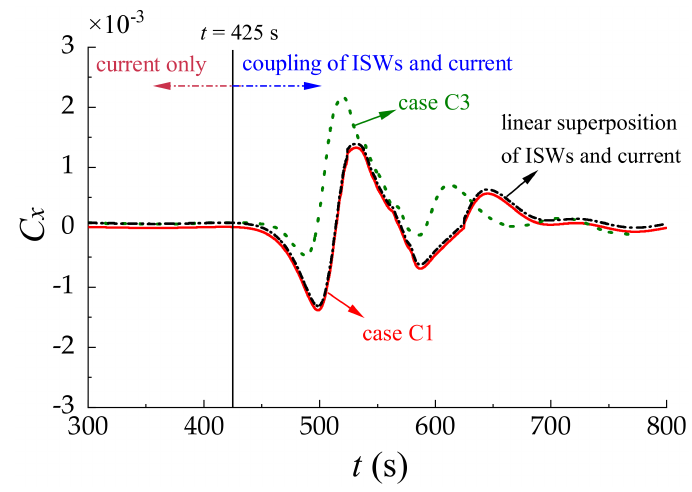
Figure 16. Comparison of the horizontal forces of Case C1 and